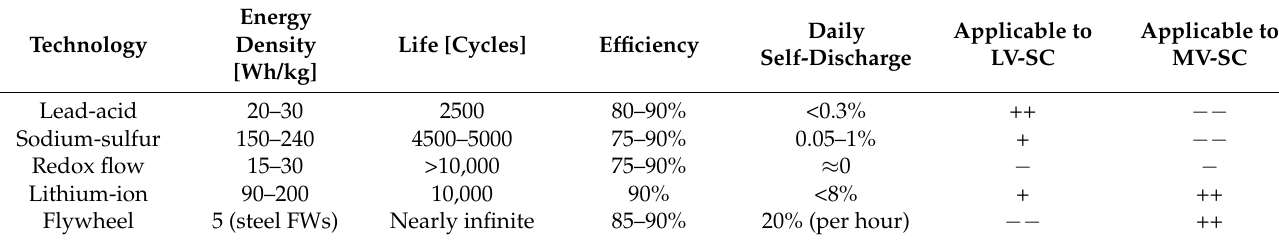
Table 9. Port energy storage system technologies, basic information, and applicability (from very high ++, to very low −− ) to case study integration of SC in the